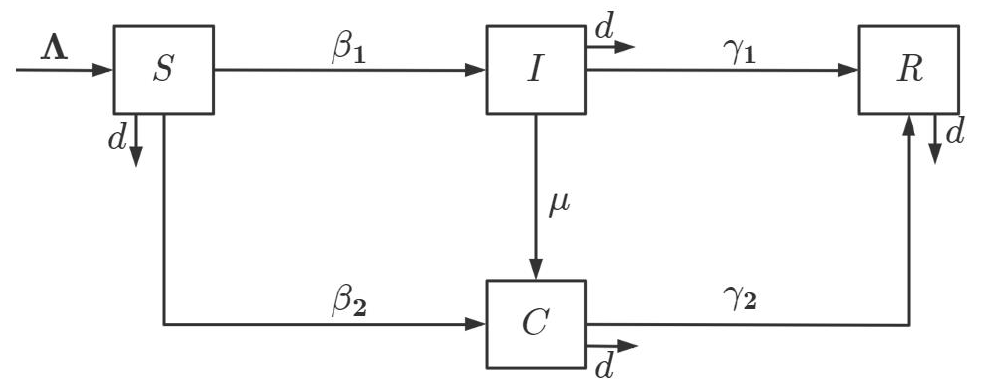
Figure 1. The basic scheme of the fractional-order SIR-C